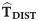
Comparison between the reference TDIST (grey line) and its reconstruction T^DIST (black line) obtained in one subject with three sensors (LF, LH, RH) worn for 22.5, weighed by the appropriate coefficients provided in Table 2.The gaps in the plot are the result of the pre-processing procedure described in S1 File.